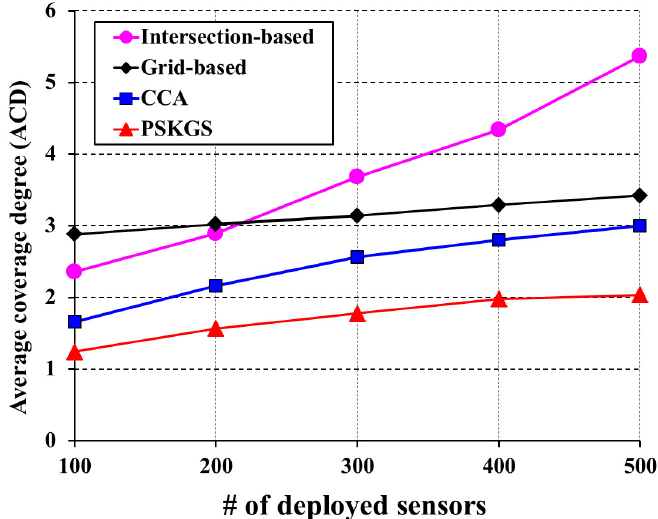
Figure 10. The performance comparison of the intersection-based [4], grid-based [5], Coverage Contribution Area (CCA) [31] and proposed PSKGS with respect to the average coverage degree for K = 1.